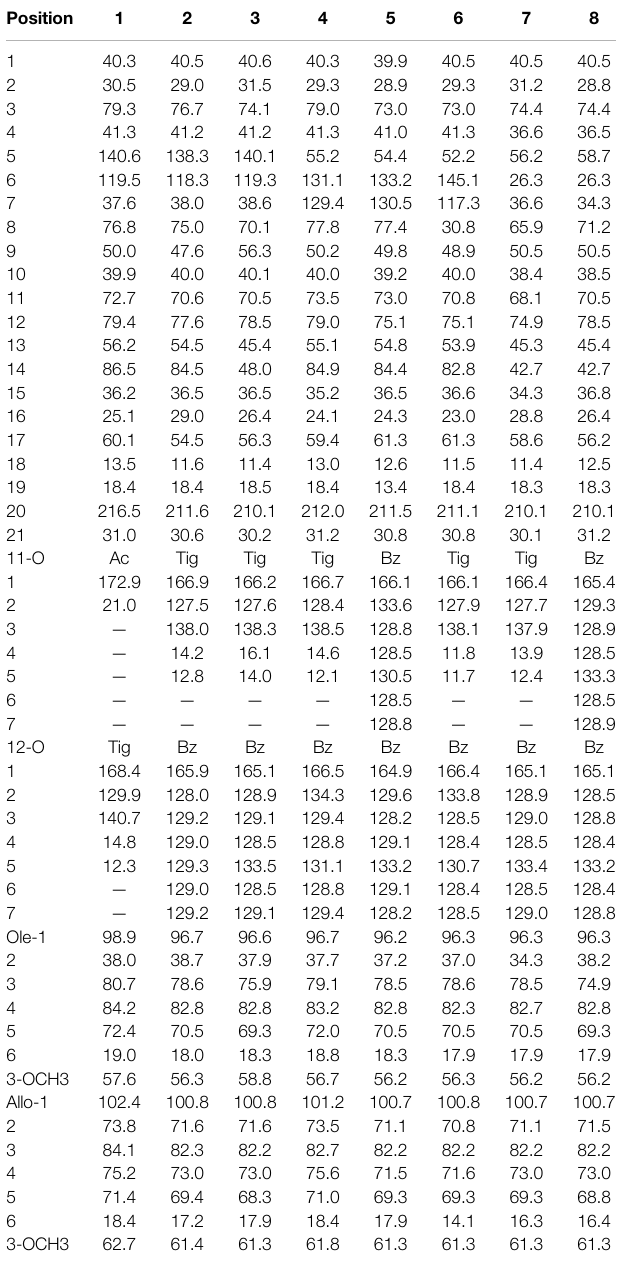
TABLE2| 13 CNMRspectroscopicdata(150 MHz,1inMeOD,and2 – 8inDMSO) for compounds 1 – 8.